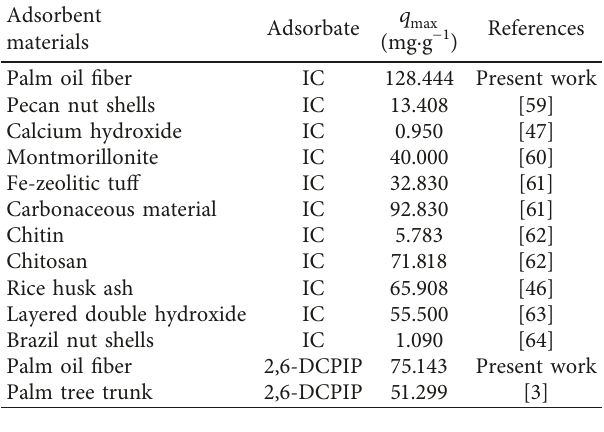
Table 3: Comparison of maximum adsorption capacities of some adsorbent materials for IC and 2,6-DCPIP, from the